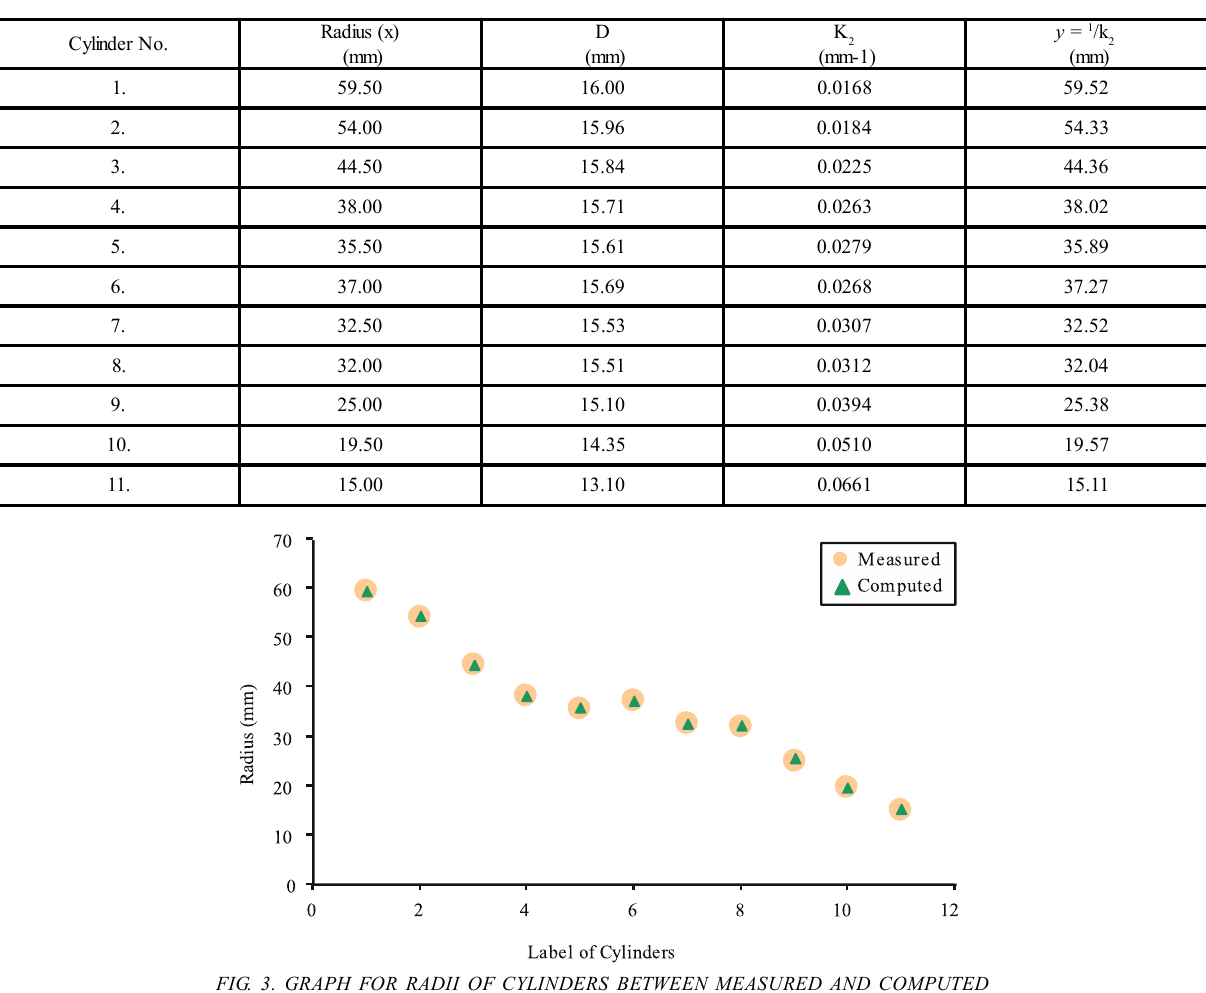
TABLE 1. CALCULATIONS OF VERTICAL CURVATURE OF CYLINDERS